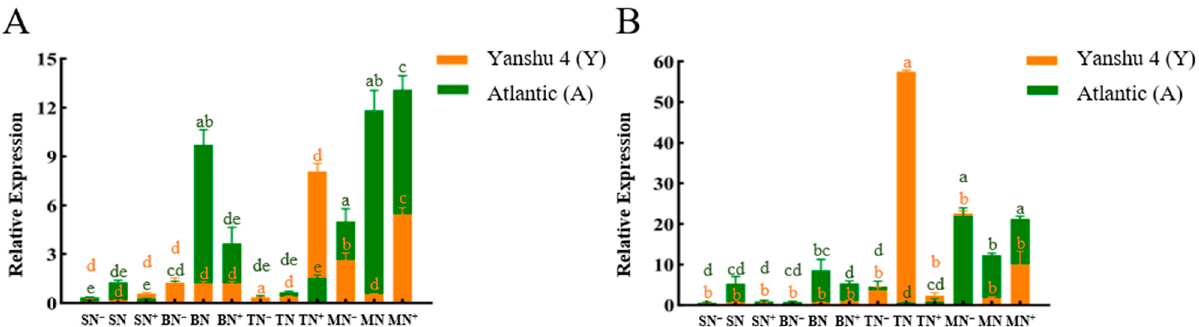
Figure 3. Relative expression of glutamine synthase gene StGS1 in two genotypes of potato under different N supply levels. ( A ) Leaf (L); ( B ) Root (R). S, B, T, and M represent seedling stage, budding stage, tuber expansion stage, and mature stage, respectively. N − , N, N + are different N supply levels, representing low N, normal N, and excess N, respectively. Different letters indicate the difference of relative gene expression in different periods under different N application levels ( p < 0.05).